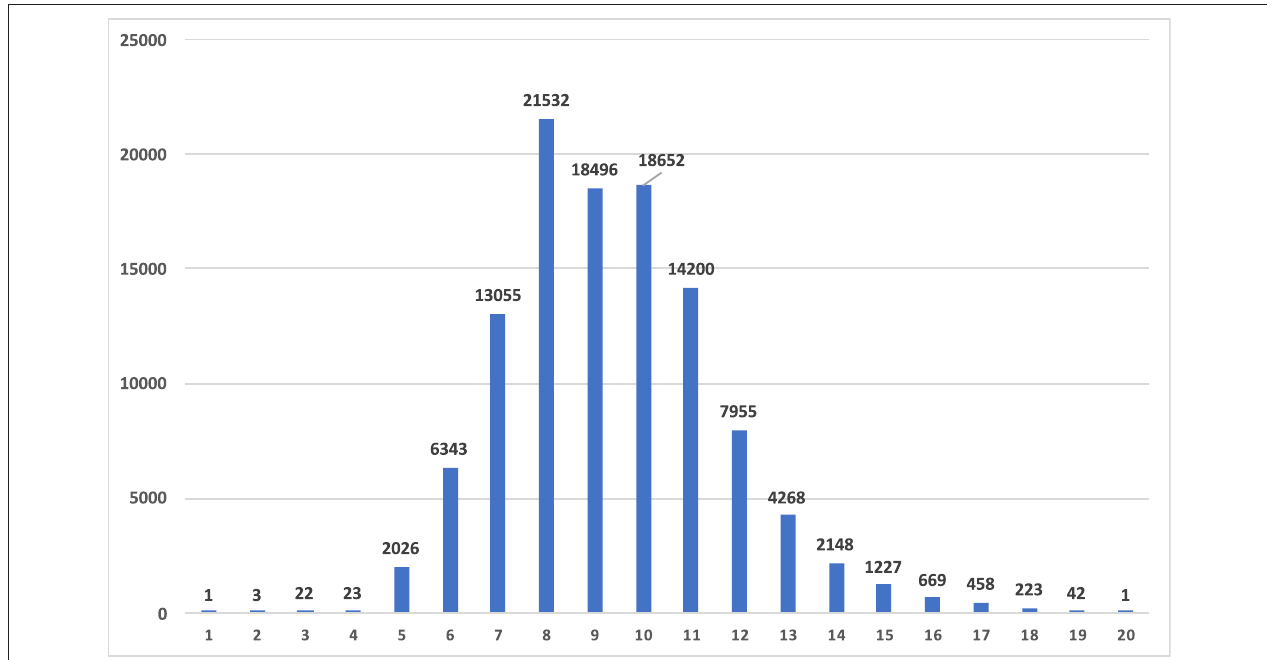
FIGURE 2 | Number of synsets per hypernymy level in the WordNet noun hierarchy, with level 1 representing the top-most and therefore most general synset { entity }.